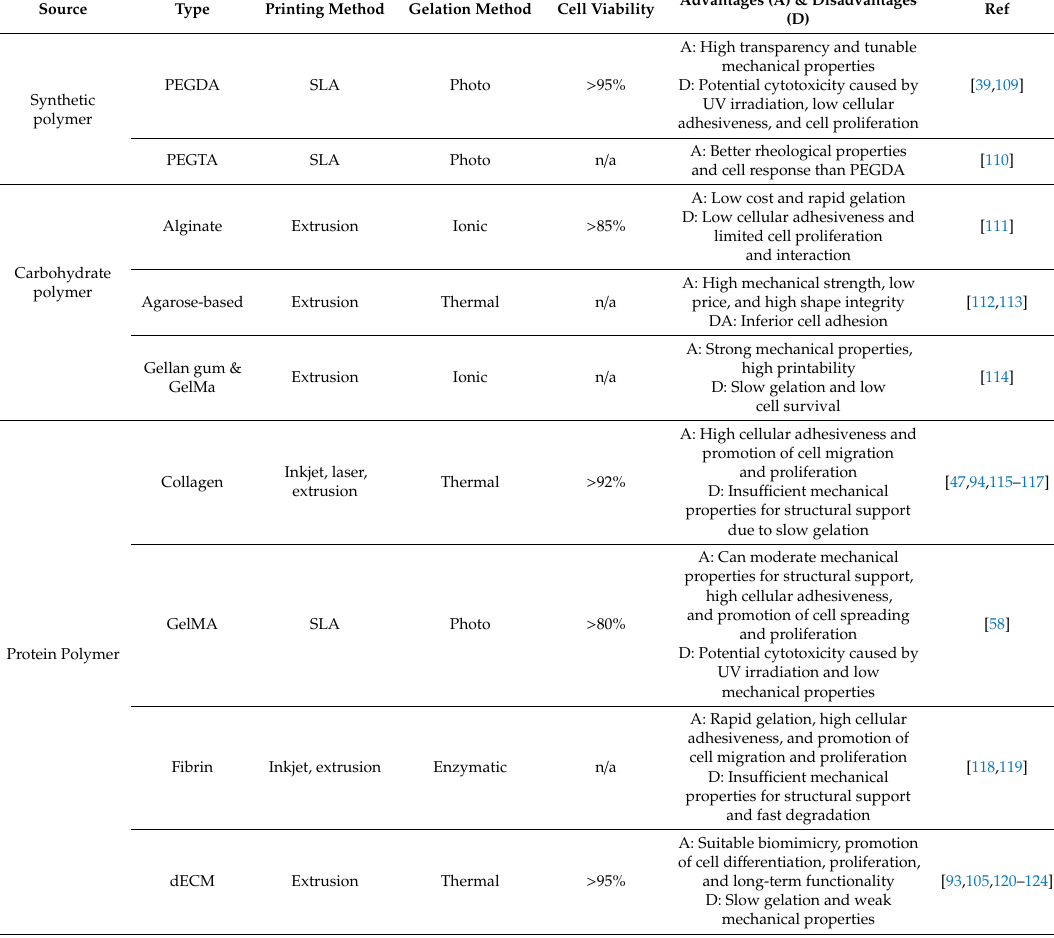
Table 2. Comparison of synthetic polymer, carbohydrate polymer, and protein polymer for bioink.